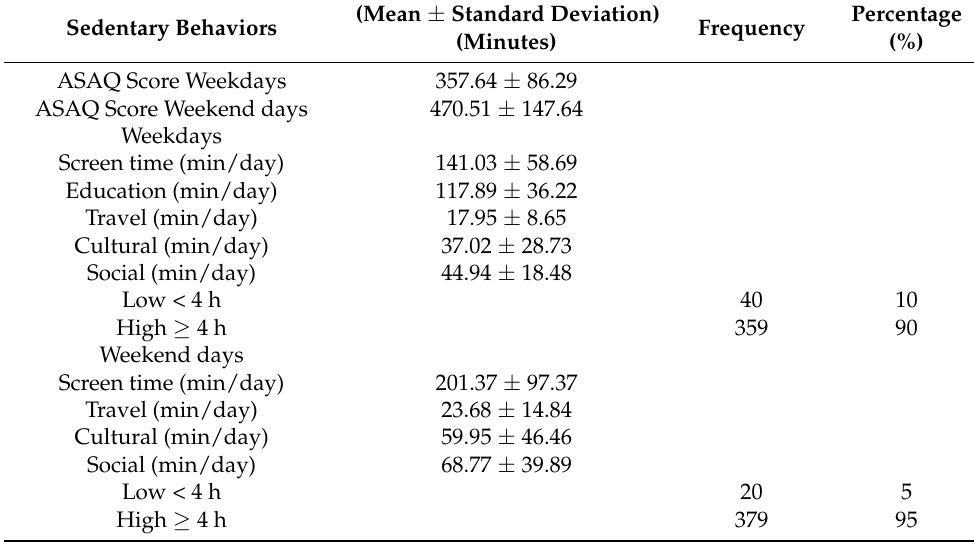
Table 4. Participants’ sedentary behavior during weekdays and